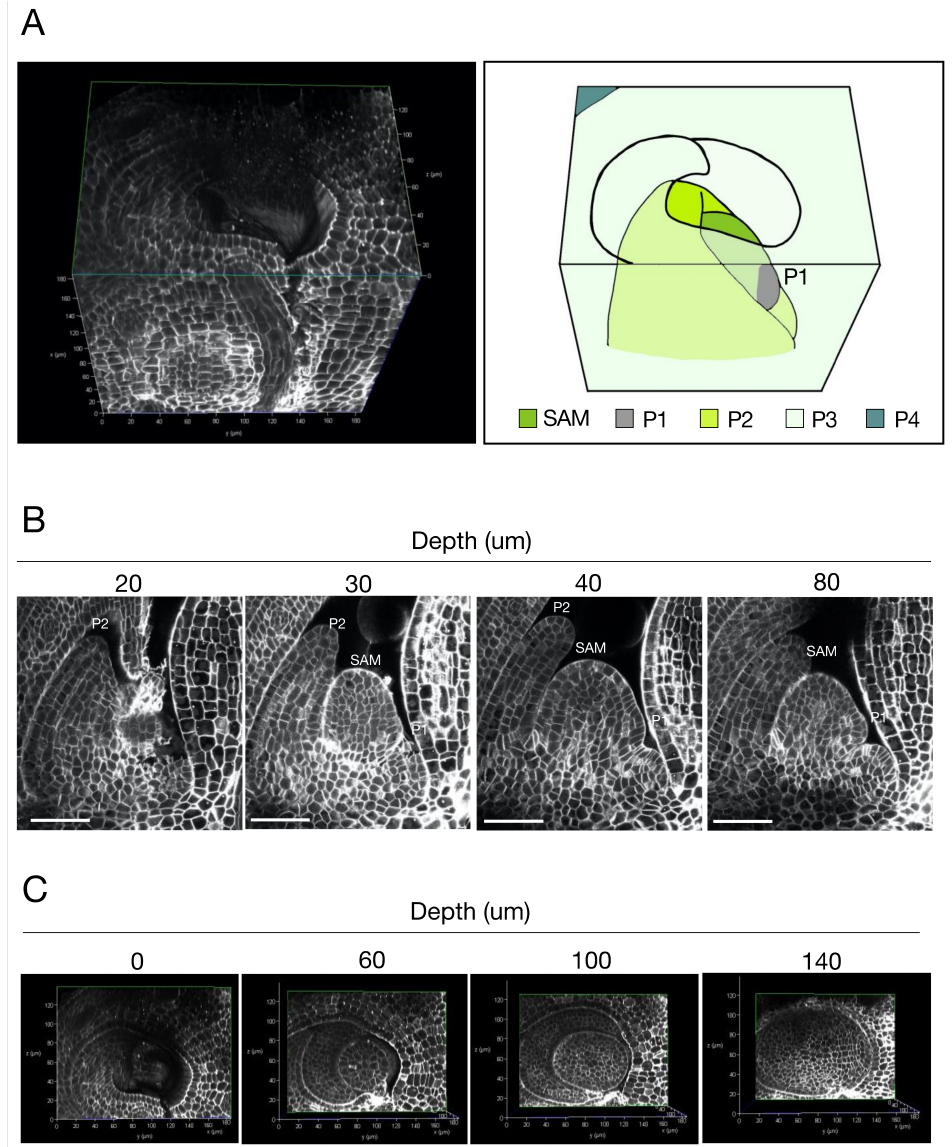
Figure 2. ( A ) Left: a 3D-reconstructed rice shoot apex. Right: a schematic presentation of the 3D- reconstructed shoot apex shown in the left panel. SAM; shoot apical meristem, P1; youngest leaf primordium (plastochron number 1), P2; second youngest leaf primordium (plastochron number 2), P3; third youngest leaf primordium (plastochron number 3), P4; fourth youngest leaf primordium (plastochron number 4). ( B ) Longitudinal sections of a rice SAM. Confocal optical sections were arranged according to the depth from the first section of serial imaging. The fluorescence intensity of cell-wall staining was adjusted for clear recognition of individual cells in the deeper sections. ( C ) Transverse sections of the 3D-reconstructed shoot apex. The transverse sections were arranged according to the depth from the top of the reconstructed image shown in ( A ). Bars; 50 µ